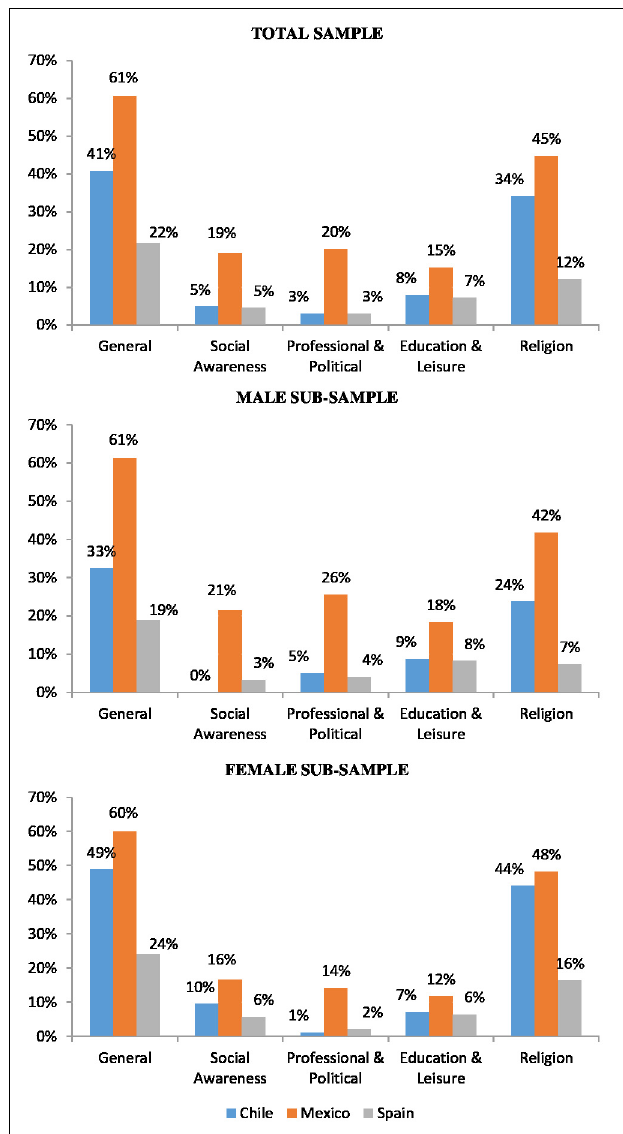
FIGURE 2 | Volunteers: general percentage and by categories (Wave: 2010–2014).